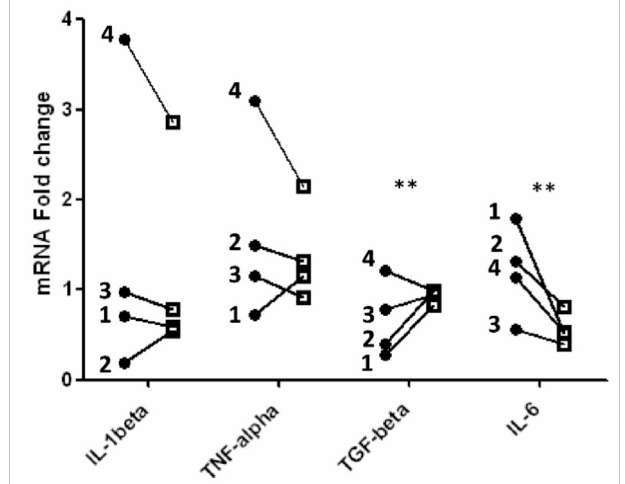
Figure 4. Fold change in cytokine gene expression level after feeding meals without (black circle) and with (black square) blueberries relative to gene expression levels detected before meals in di ff erent subjects (1, 2, 3, 4); ** Significant di ff erences ( p -value <